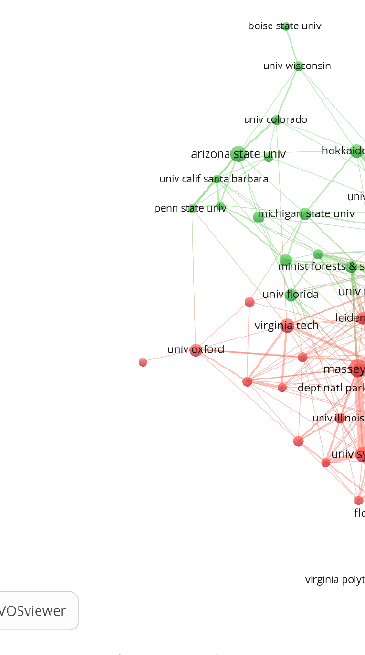
Figure 6. Map of “Research Institutions”.